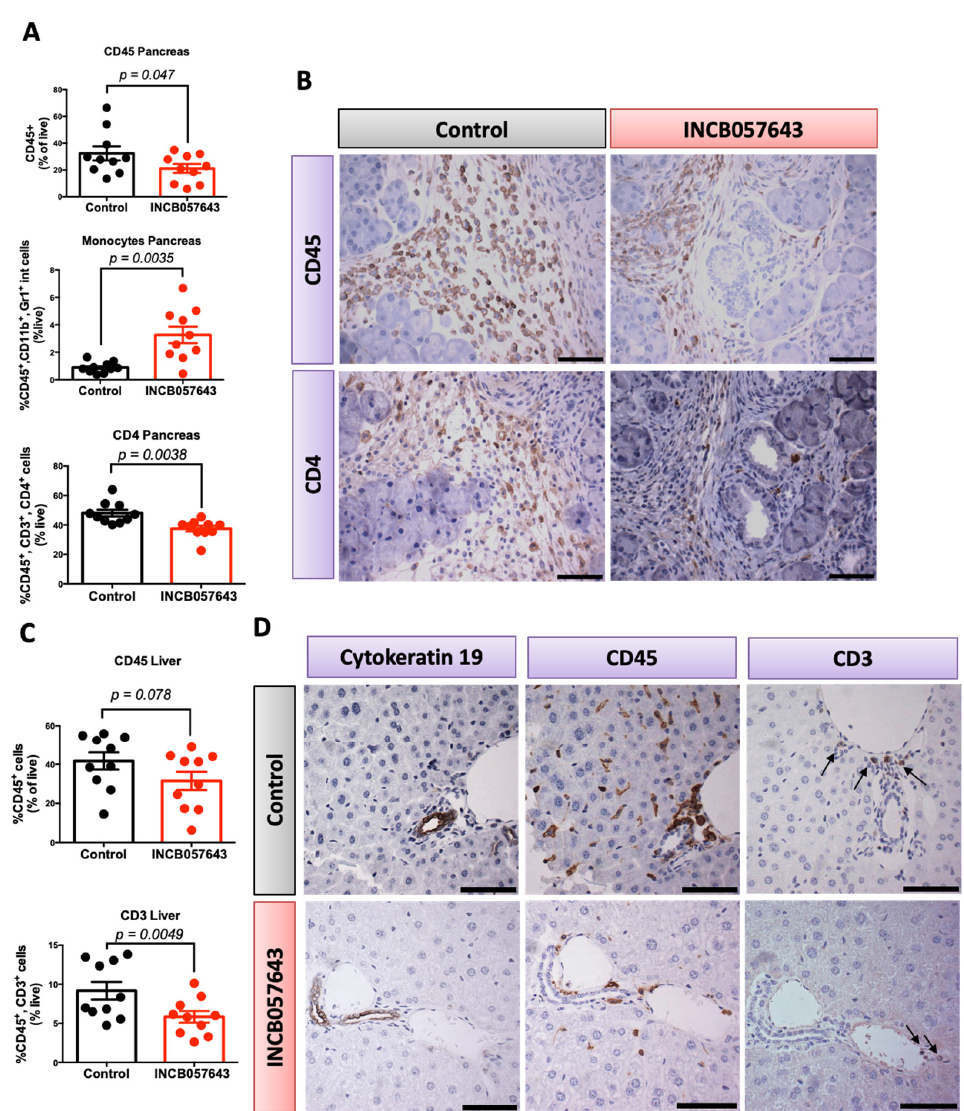
Figure 2. INCB057643 changes the inflammatory microenvironment in the pancreas and liver of KPC mice. KPC mice were treated with INCB057643 5 times a week for 16 weeks, starting at 4 weeks of age. Blood, pancreas, liver, lung and spleen were collected. n = 10 mice/group. CD45 + immune cells, CD45 + , CD11b + , Gr1 + low cells (monocytes), CD45 + , CD3 + (CD3 T cells), and CD45 + , CD3 + , CD4 + (CD4 T cells) were analyzed by flow cytometry in the pancreas ( A ) and liver ( C ). Flow cytometry results were confirmed by immunohistochemistry in both pancreas ( B ) and liver ( D ). Arrows on panel ( D ) indicate positive CD3 T cells. Scale bar 30 µm.